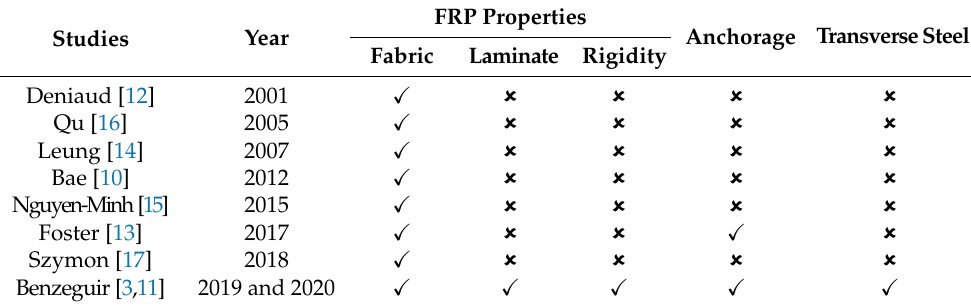
Table 5. Status of the consideration of some shear strength influencing parameters.